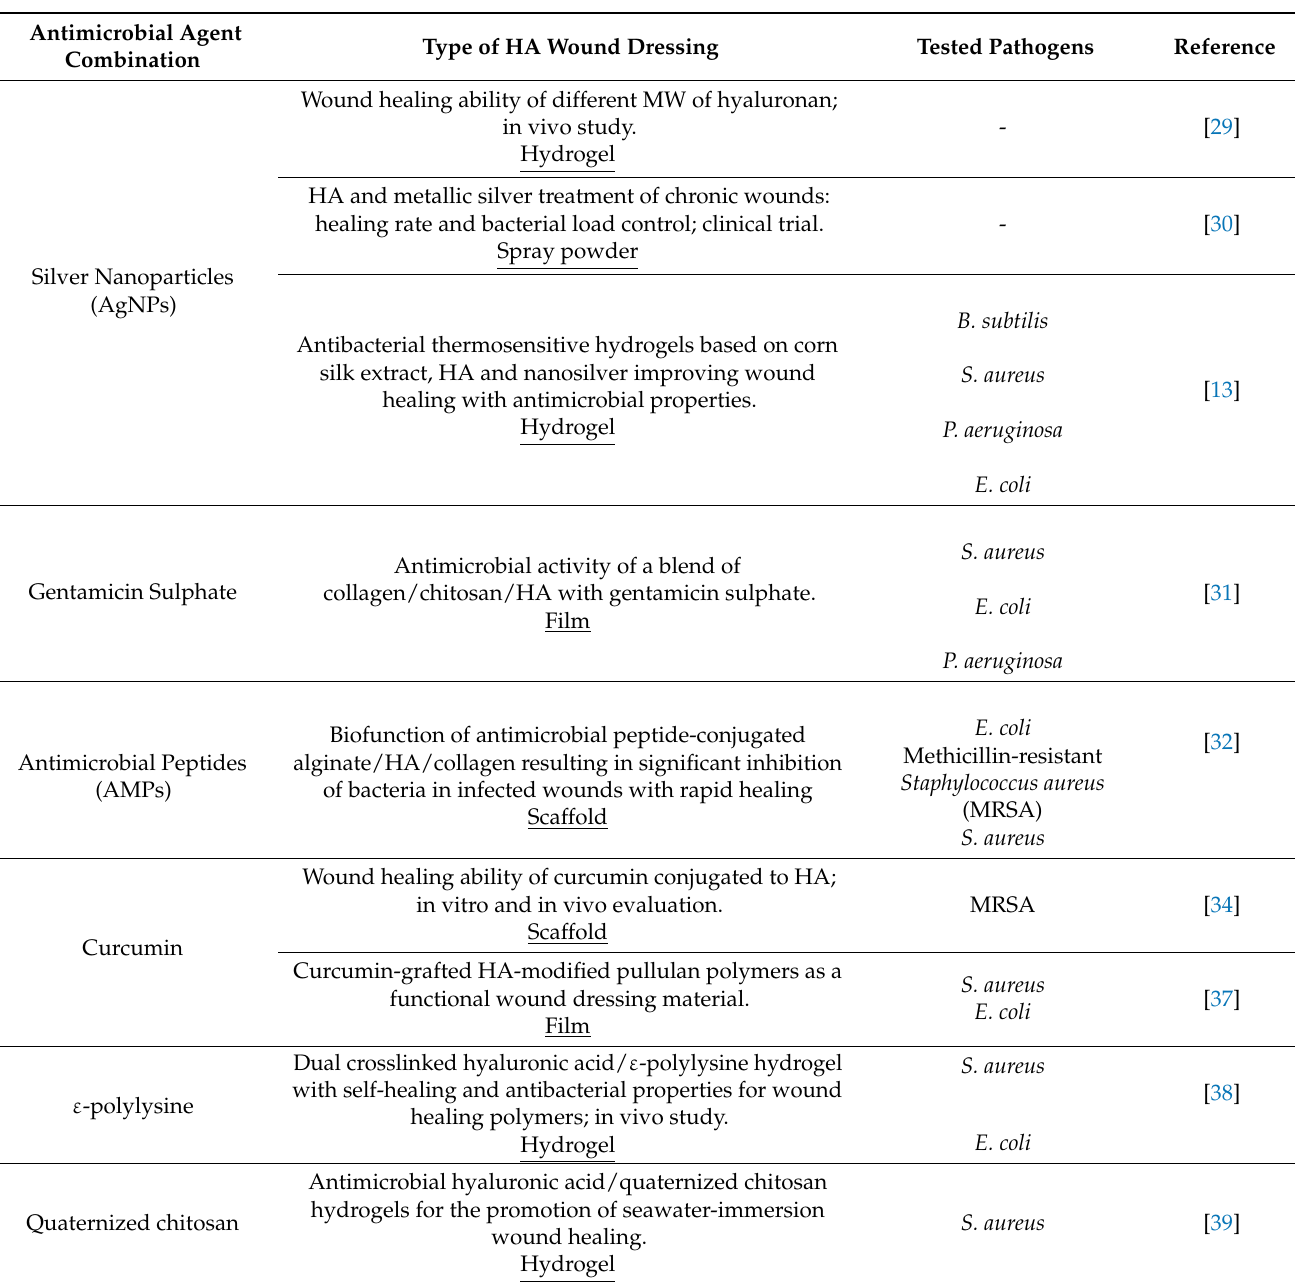
Table 1. Different types of HA-based devices combining both synthetic and natural antimicrobial agents with proven antimicrobial